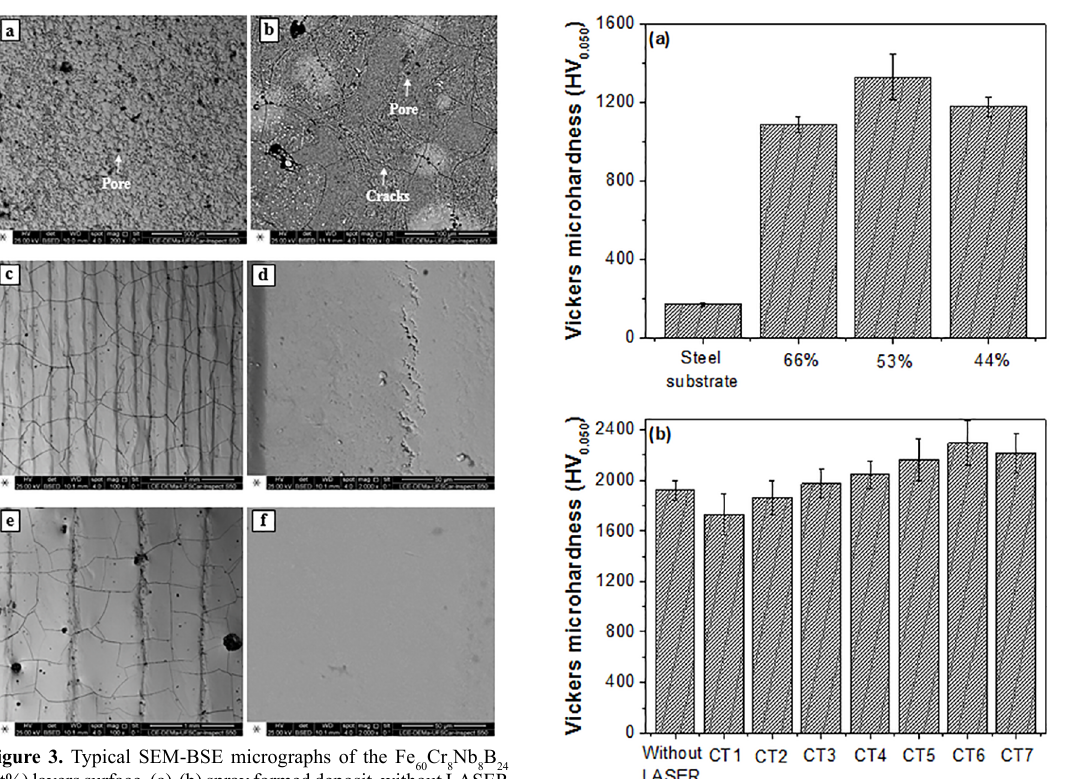
Figure 3. Typical SEM-BSE micrographs of the Fe (at%) layers surface, (a)-(b) spray formed deposit, without LASER application, and after LSR process at LASER power of 800 W and scanning speed of 150 mm/s with (low interaction time - 6.7. ms) with different overlaps: (c)-(d) 80% and (e)-(f) 20%, respectively.